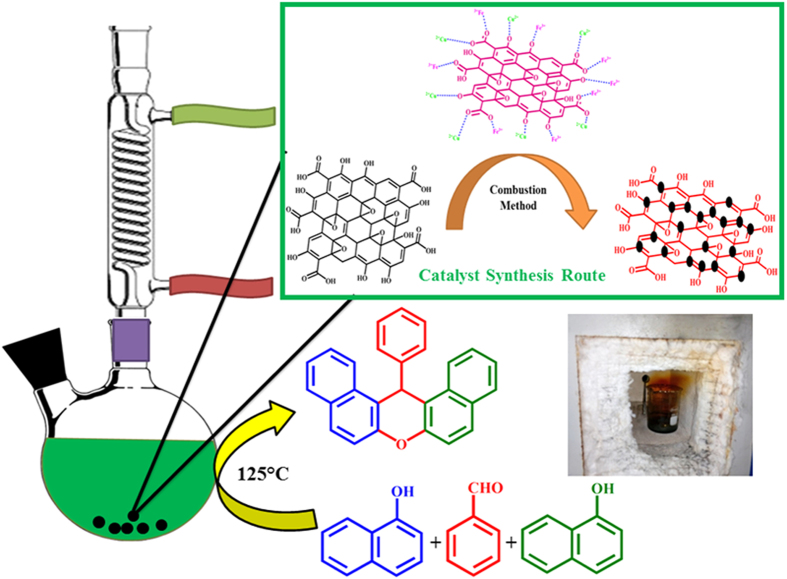
Preparation of GO-CuFe2O4 nanocomposite via SCS route for synthesis of xanthenes.